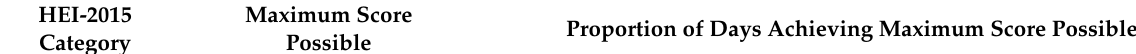
Table 6. Daily maximum HEI-2015 component scores among the standard meal and vegetarian alternative HEI-2015 component